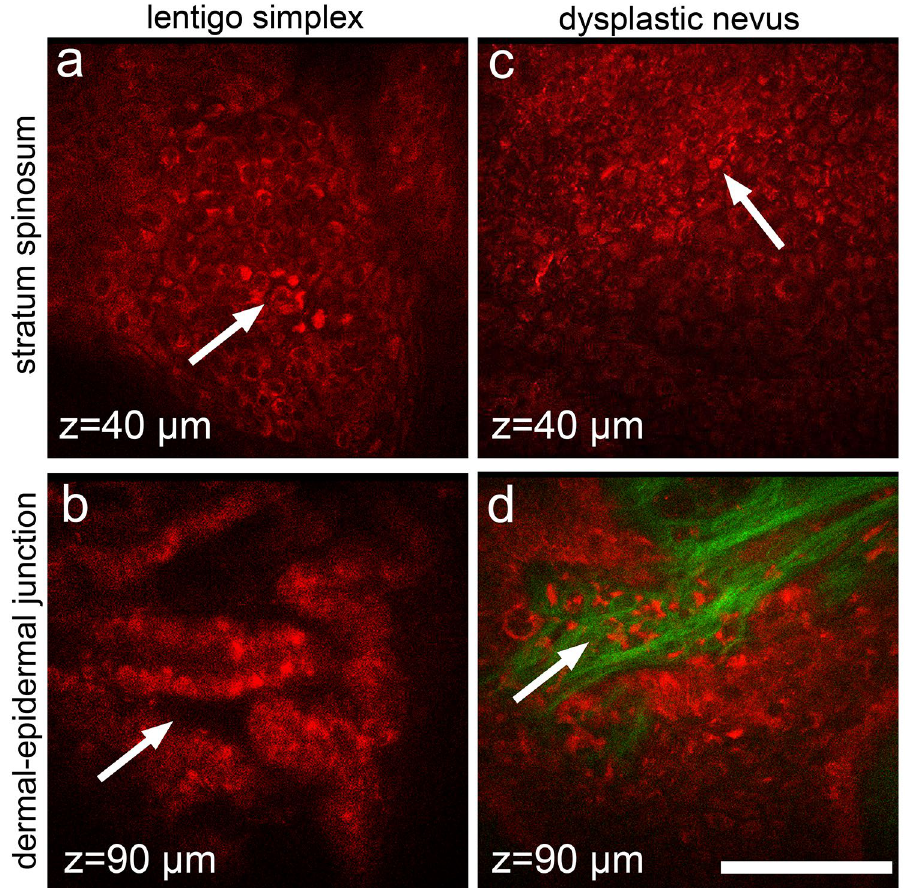
Figure 3. MPM features of benign lesions in dermoscopic equivocal group. In lentigo simplex ( a , b ), bright nucleated cells in spinous layer ( a ) and brain-like structure in dermal–epidermal junction ( b ) are shown by the arrows. In dysplastic nevi ( c , d ), bright pagetoid cells ( c ) in spinous layer and atypical cells in rate-ridges ( d ) are shown by the arrows. Autofluorescence from the cells (red) and SHG signal from collagen (green) are shown. Imaging depth is marked on the images. Scale bar is 100 µm, applicable to all